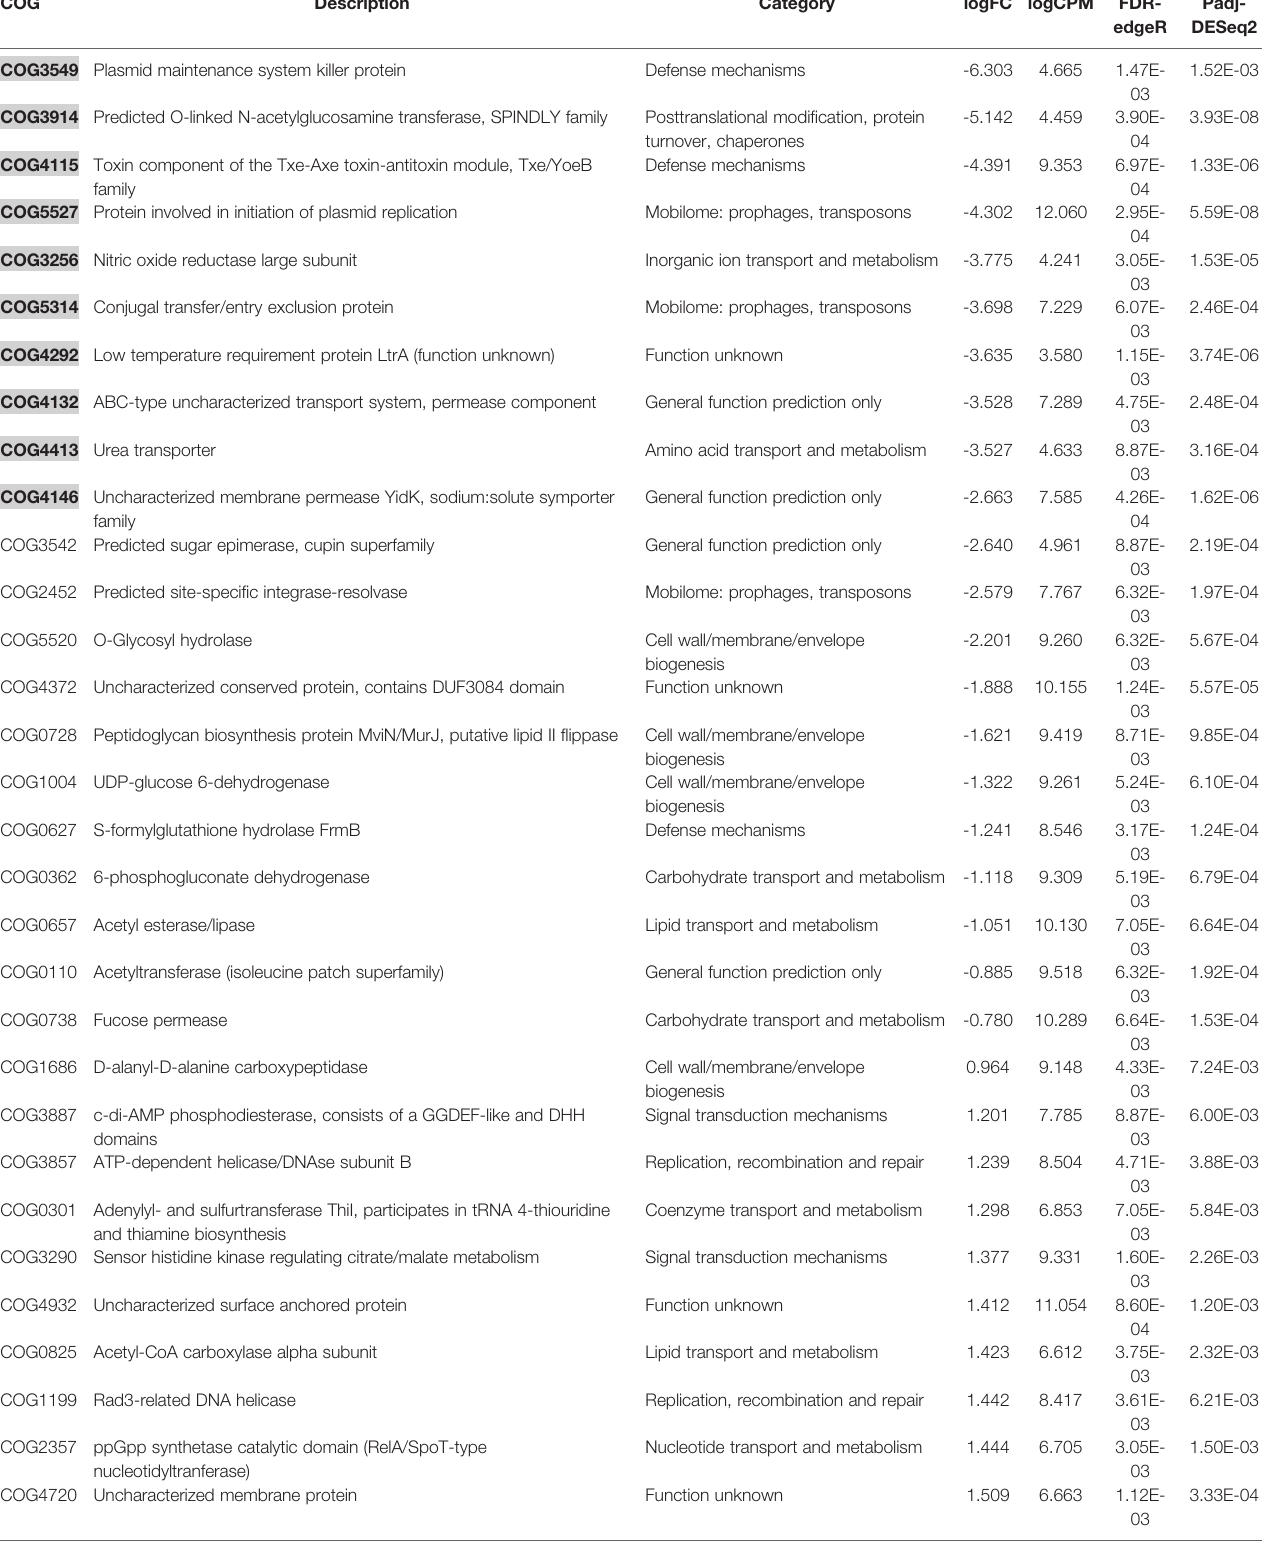
TABLE 2 | Signi fi cant Abundance Differences of COG Between Formula-fed and Breast-fed